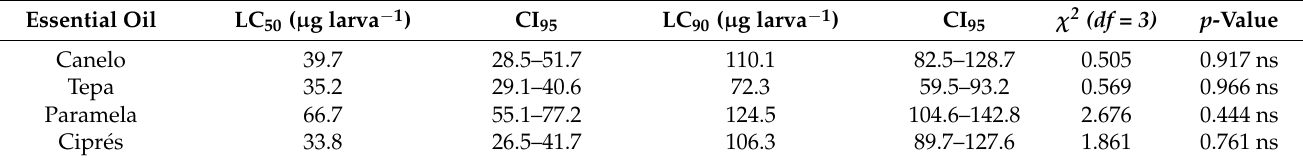
Table 3. Insecticidal activity of the four essential oils from Patagonian plants against 3rd-instar larvae of Spodoptera littoralis; df = degrees of freedom, ns = not significant (p > 0.05) .